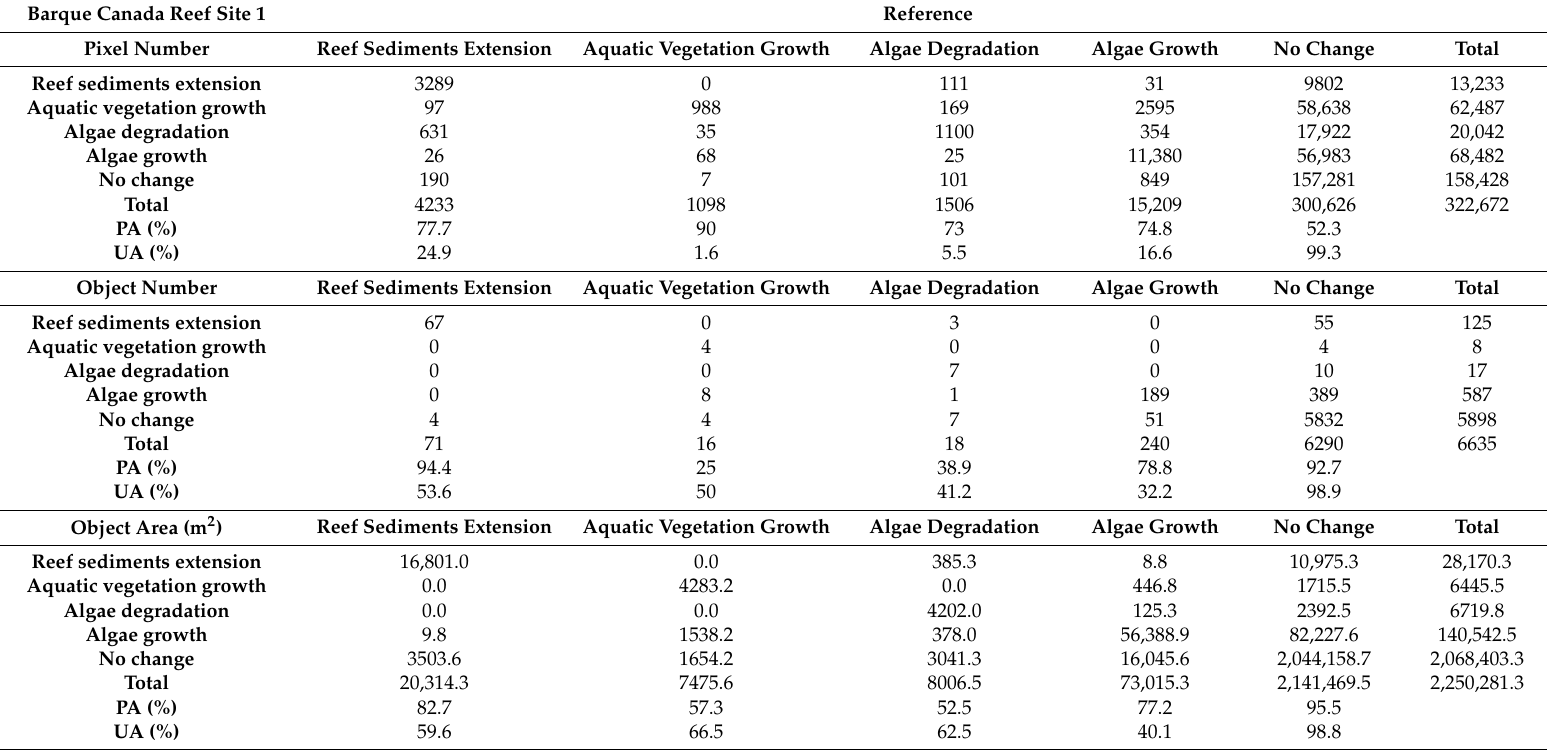
Table 6. Confusion matrices of PBCD and OBCD results for Barque Canada Reef Site